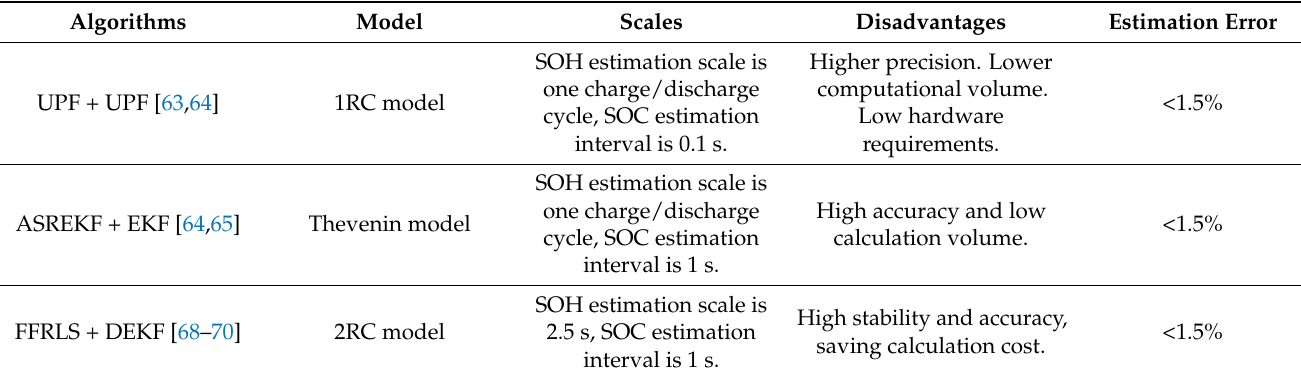
Table 6. Joint multi-timescale SOC/SOH-estimation methods.